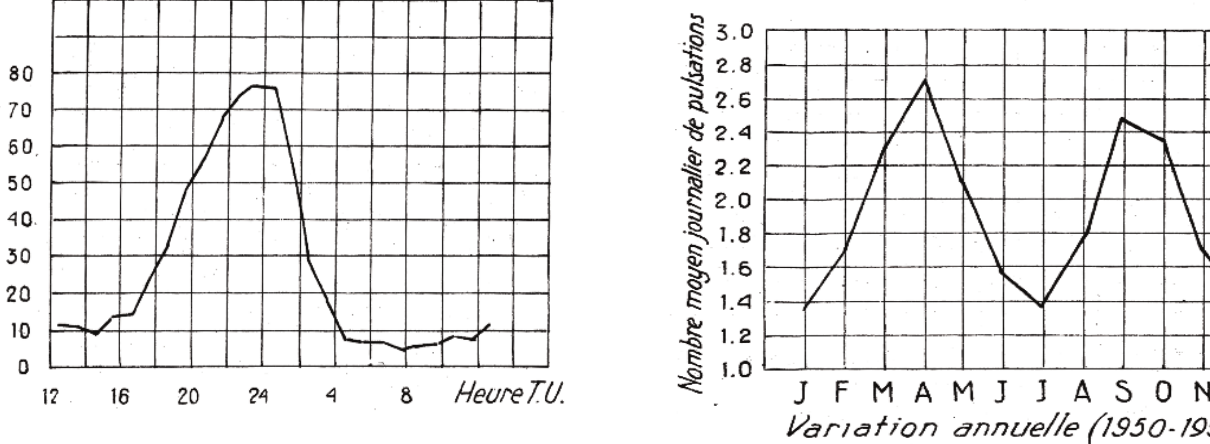
Figure 7. Variation annuelle des pt à Tamanrasset de1950 à 1957 (d’après Billaud et